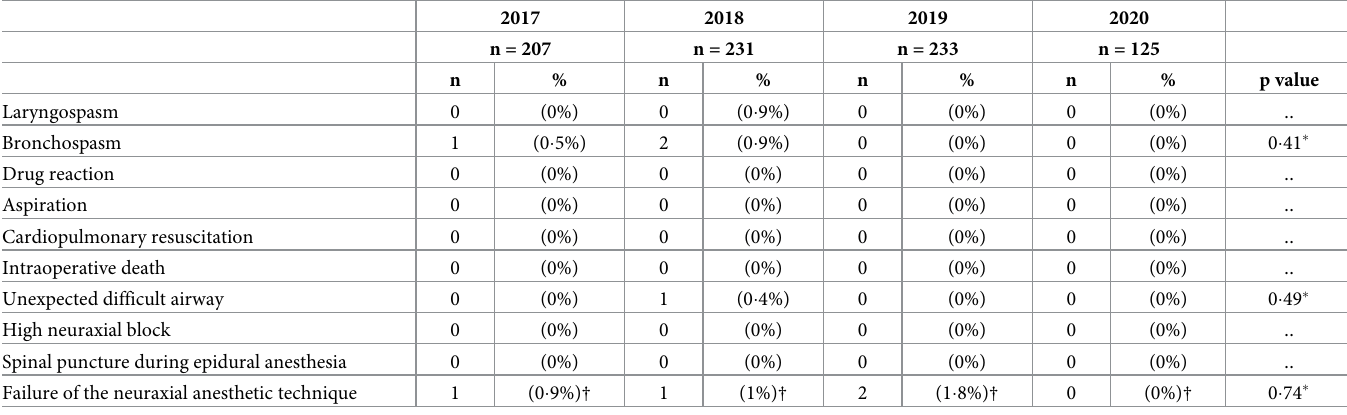
Table 5. Anesthesia-related adverse events.